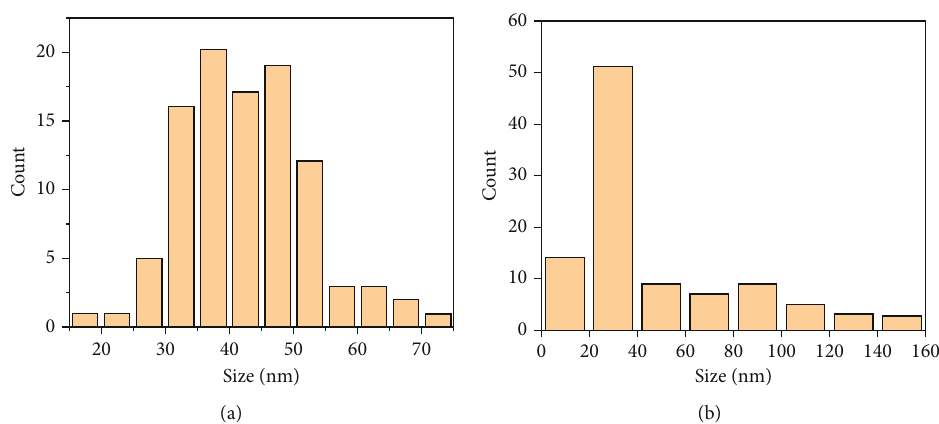
Figure 5: The diameter of Fe